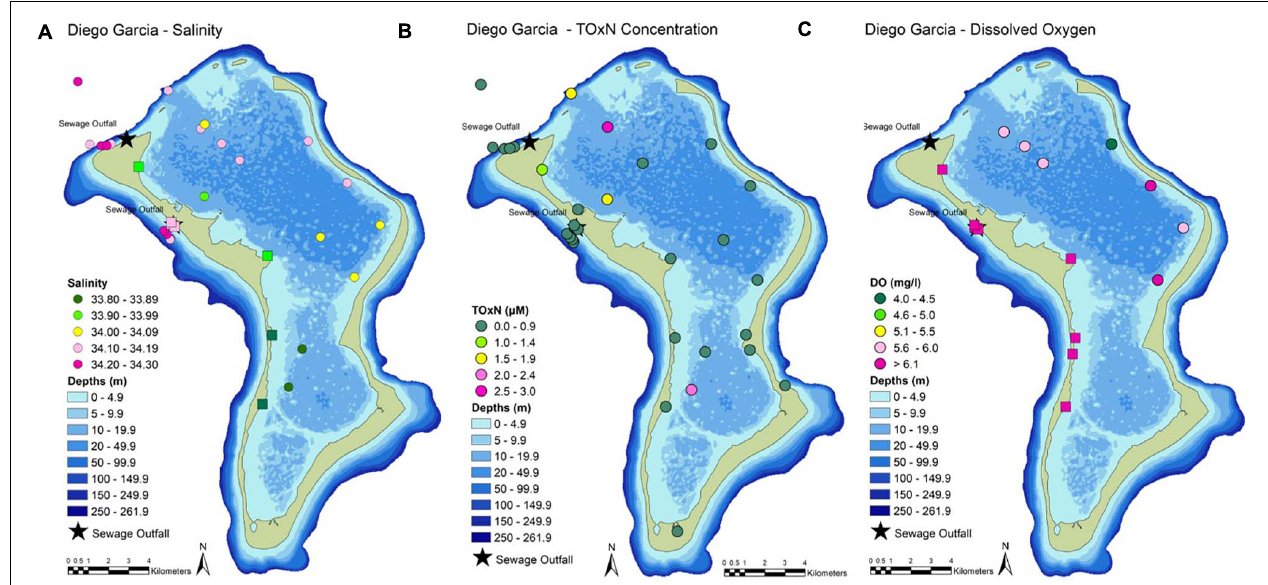
FIGURE 2 | Near-surface measurements of (A) salinity, (B) nutrient concentrations (as TOxN, total oxidizable nitrogen = nitrate + nitrite), and (C) dissolved oxygen. Oxygen levels below 6 mg l − 1 indicate oxygen deficiency. Circles = results from the CTD. Squares = results from the surface probe.